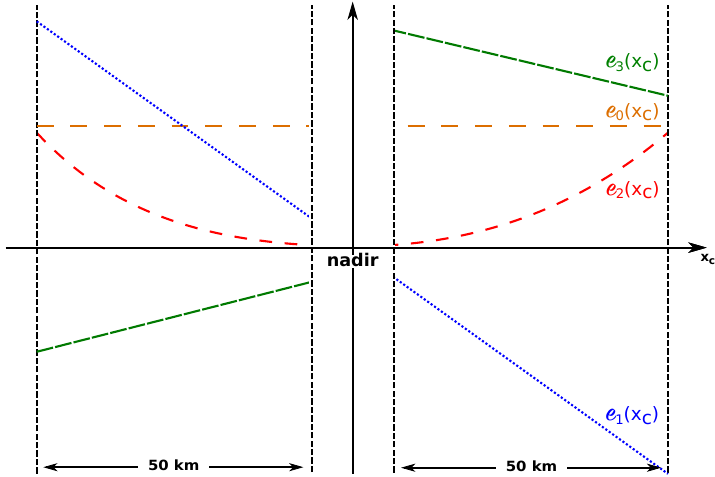
Figure 3. A schematic representation of the SWOT error distributions across track. The errors e 0 , e 1 , e 2 , and e 3 correspond respectively to the timing, the roll, the baseline dilatation, and the phase